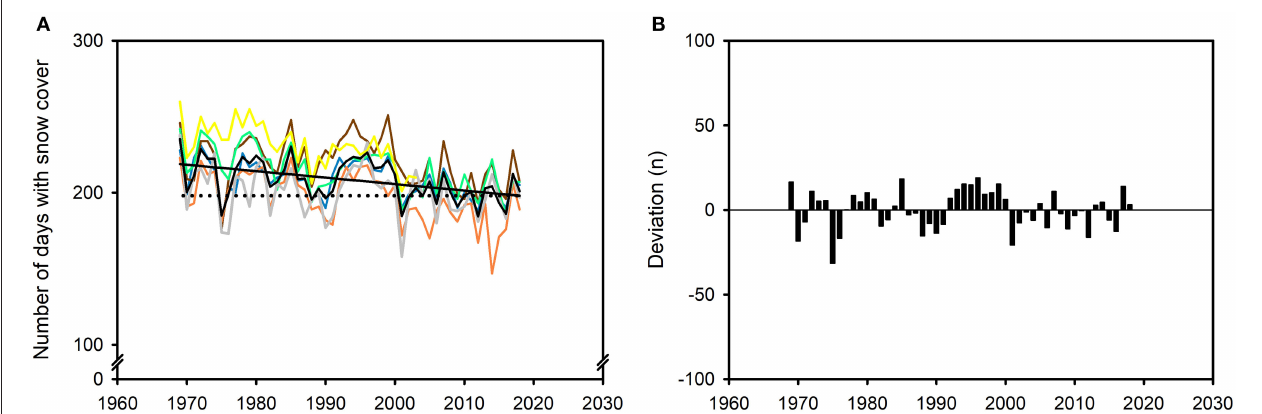
FIGURE 16 | Number of days with snow cover in winter (October to April, O-A) on the reindeer winter pasture area of Finnmarksvidda ( Figure 7 ), 1969–2018. Data from six weather stations: Cuovddatmohkki, Karasjok, Kautokeino, Sihccajavri, Skogfoss and Suolovuopmi ( Figure 7 ). (A) Annual mean value for all stations (black curve) and for at each station (colored curves; days) and the trend in number of days derived from a linear regression model (data combined for all stations): Number of days year = [(0.43 · year) + 1058.5], r 2 = 0.23, p < 0.001 (black line). The average number of days with snow cover exceeded the regression value for 2018 (198 days) in 29 (91%) of the first 32 years of the series (1969–2000) but in only 10 (56%) of the last 18 years (2001–2018; dotted line). (B) Annual deviations from the model for the combined dataset ( n ). For color codes, see Figure 9 ; gray: Skogfoss.